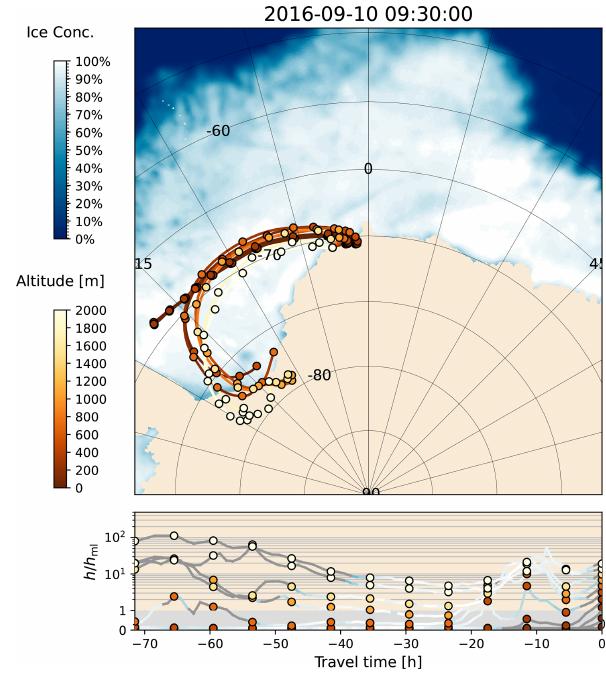
Figure 3. Example for back trajectories ending at Neumayer Sta- tion on 10 September 2016 at 09:30UTC. The trajectories end at the centre of the profile retrieval layers. In the top panel, the altitude of the air parcels above ground level (a.g.l.) are given by the line colour (red to white colour scale), and each circle indicates 6h of travel- ling time, with the circle colour indicating the end-point altitude. Blue to white colours indicate the OSI-SAF sea ice concentration (© 2018 EUMETSAT) as denoted in the respective colour bar. The bottom panel shows the time–height cross section, with the height being normalised to the mixing-layer height. The line colour indi- cates the sea ice concentration below the air parcel (blue to white), with locations over the continent shown in grey. Note the change in y -axis scale from linear between 0 and 1 (grey area, corresponding to the vertical extent of the mixing layer) to logarithmic above